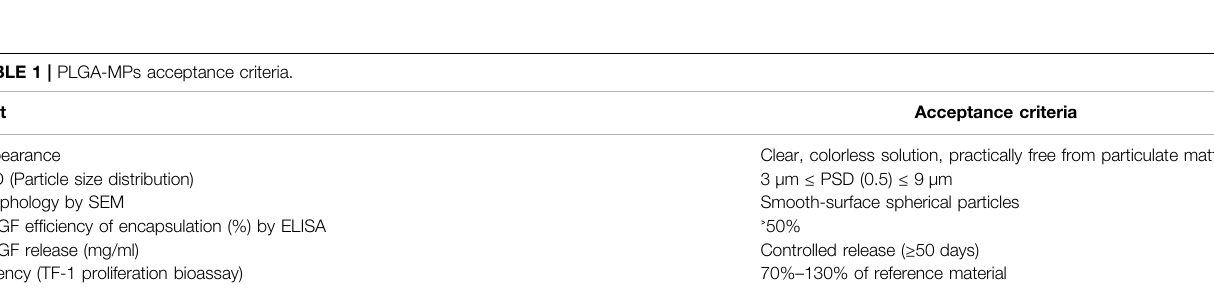
TABLE 1 | PLGA-MPs acceptance criteria.